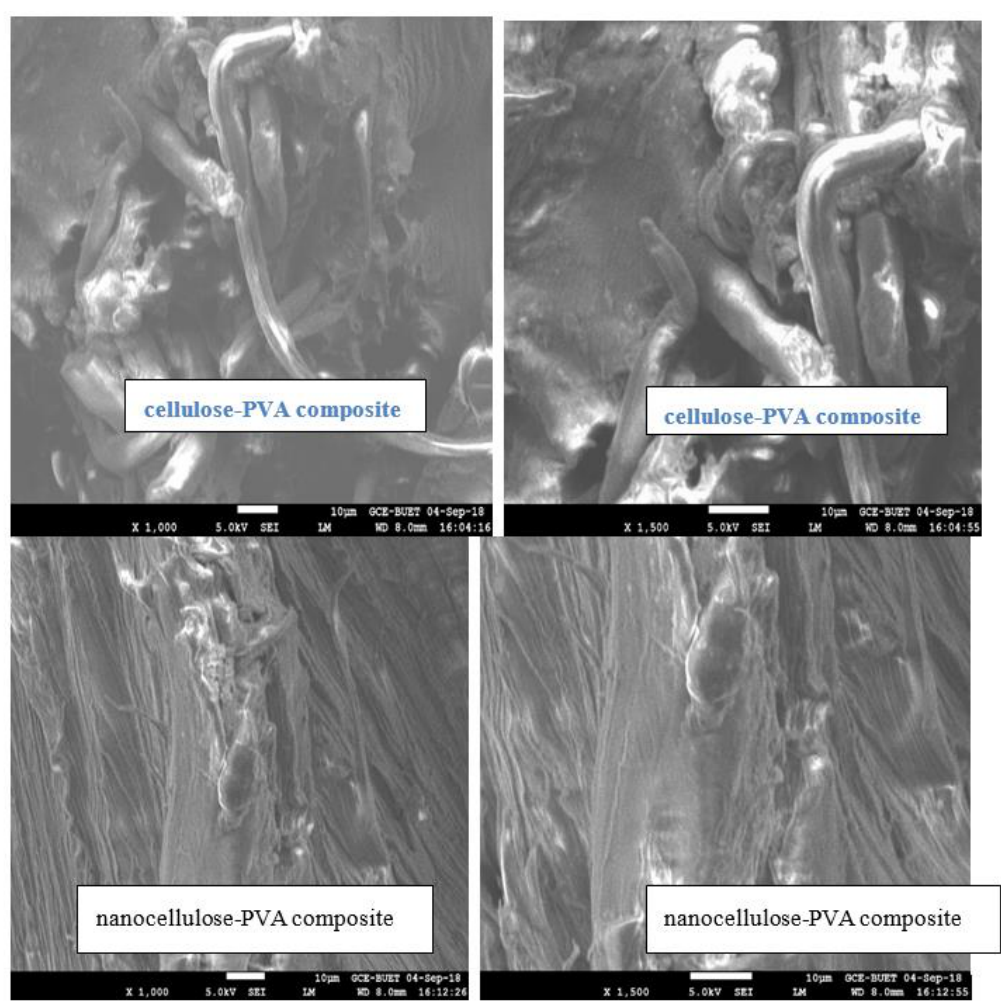
Figure 4. SEM of cellulose-PVA composite and nanocellulose-PVA composite.